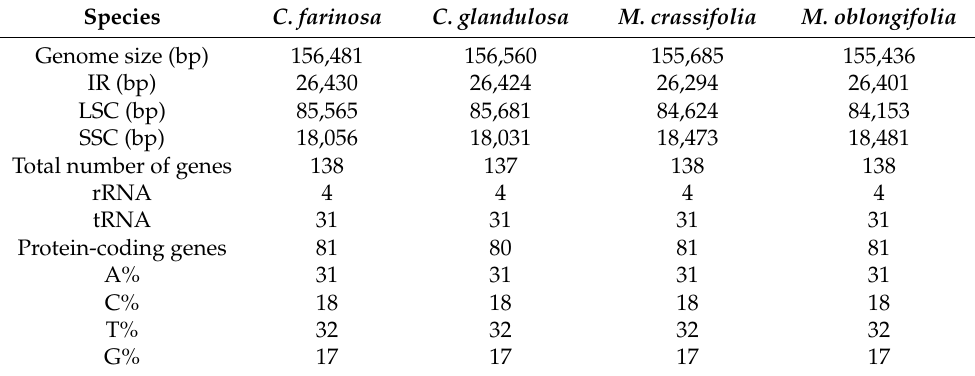
Table 1. Base content in the C. farinosa , C. glandulosa , M. crassifolia and M. oblongifolia chloroplast genomes.